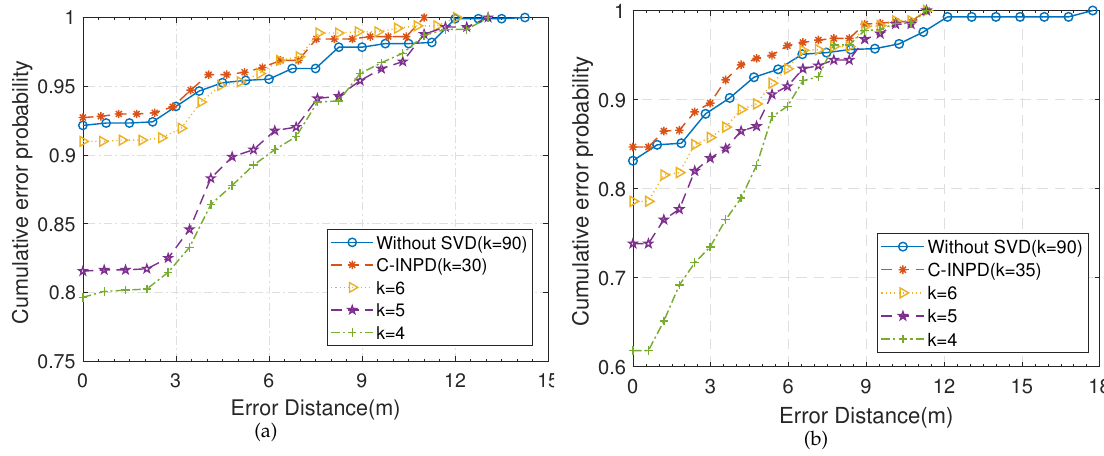
Figure 19. The positioning performance of different parameter K in SVD. ( a ) The CDF comparison in the integrated room. ( b ) The CDF comparison in the garage.